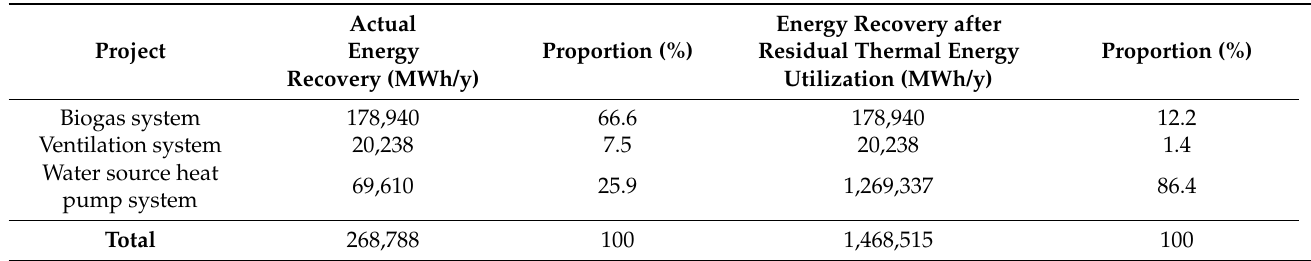
Table 4. Calculations of energy recovery in Gaobeidian WWTP.